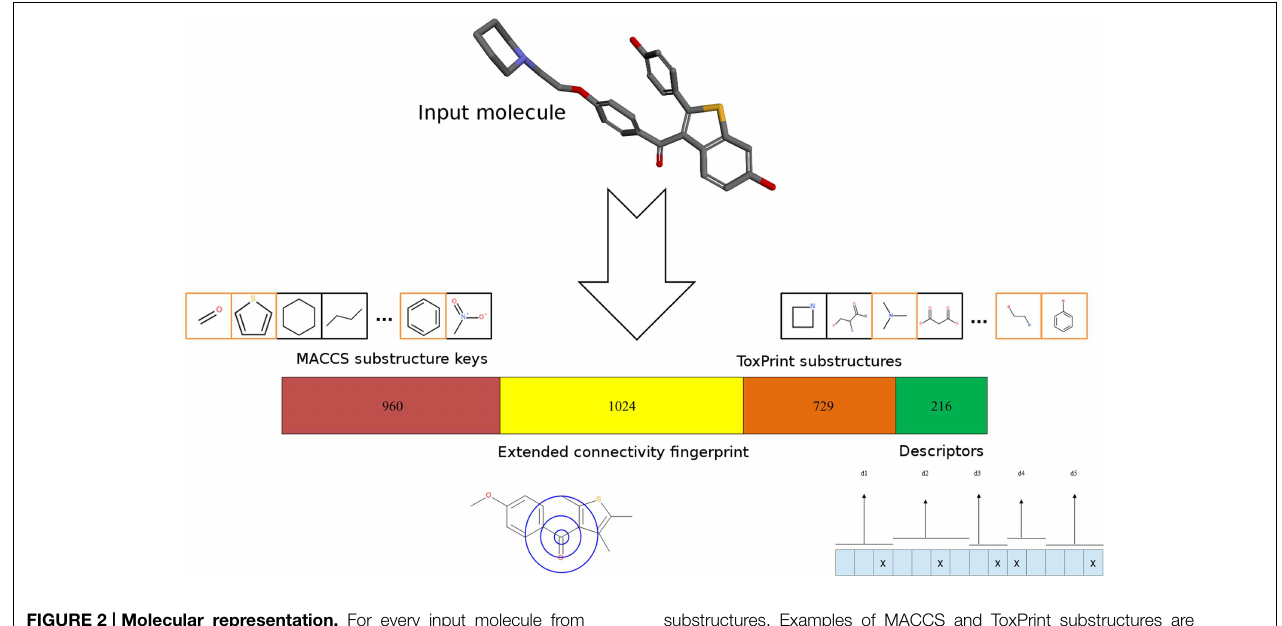
FIGURE 2 | Molecular representation. For every input molecule from the Tox21 data set, different 2D-fingerprints are calculated and combined. The concatenation consists of MACCS keys (960 bits), the extended-connectivity fingerprint ECFP4 (1024 bits), ToxPrint (729 bits) and a fingerprint developed from topological descriptors (216 bits). Both MACCS as well as ToxPrint fingerprints encode the presence of specific